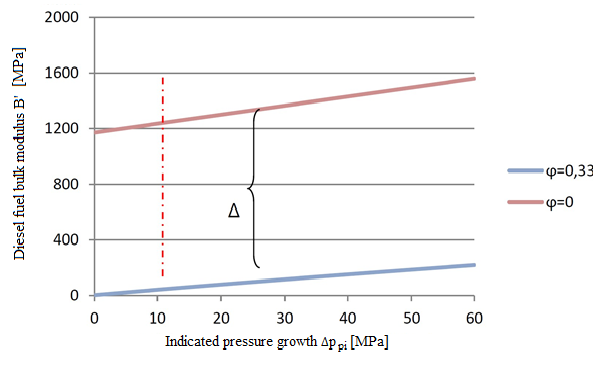
Fig. 8. The bulk modulus B ' depends on the indicated pressure of the pump, where φ = 0 means pure diesel fuel, φ = 0.33 determines the ratio of the gas volume V a to V o for the simulation of a hypocycloidal pump